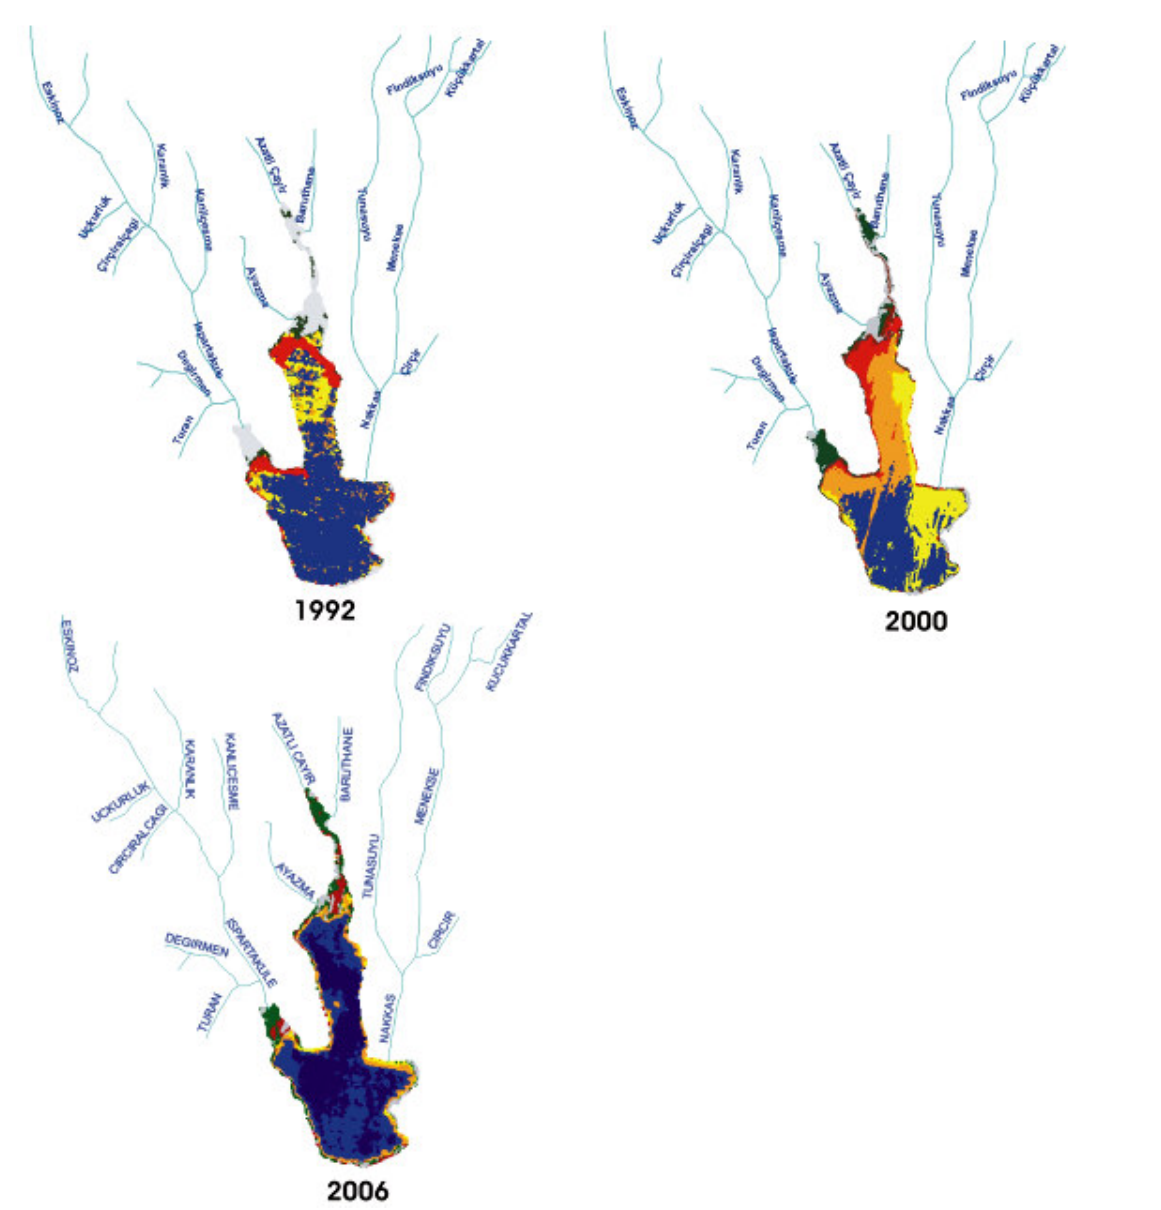
FIGURE 7 . WQ classified images of Küçükçekmece Lake for 1992, 2000, and